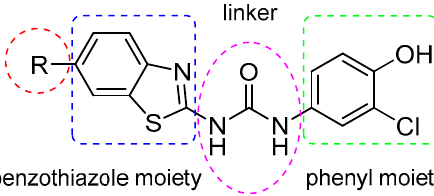
Figure 2. Design of benzothiazolylurea-based 17 β -HSD10